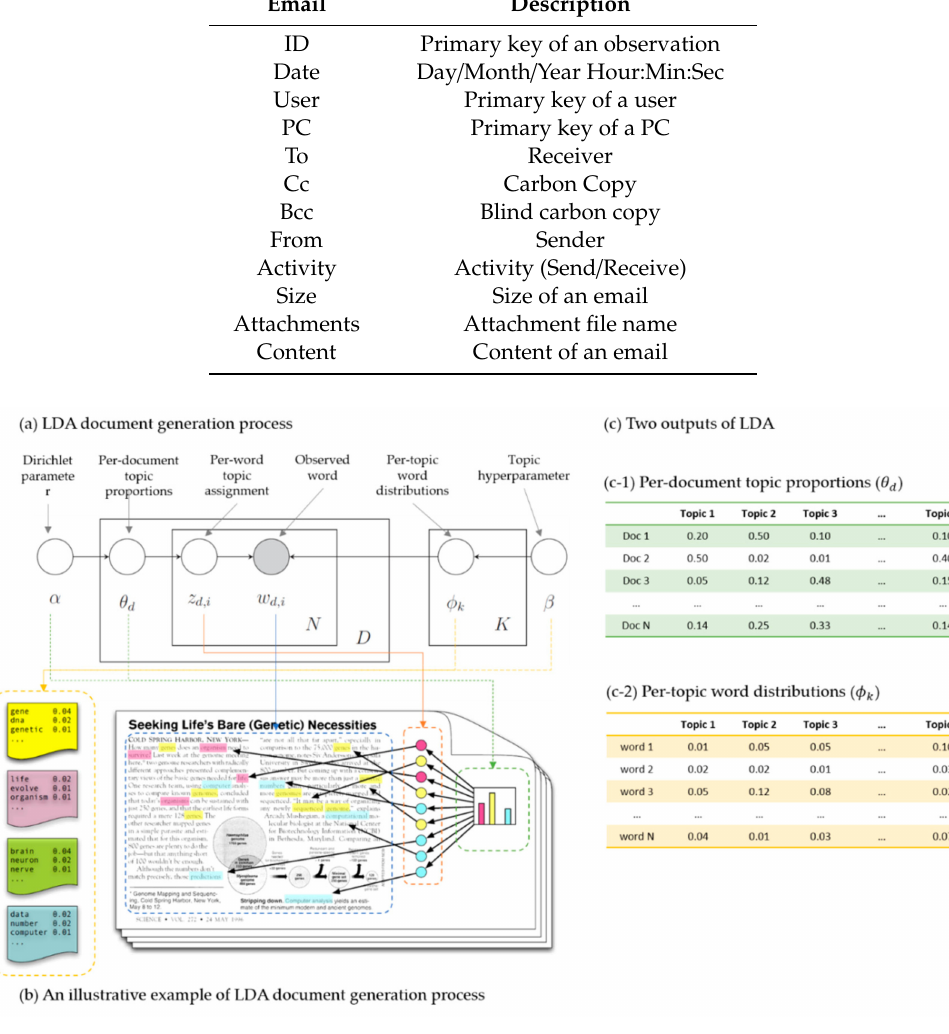
Figure 1. Latent Dirichlet allocation (LDA) process and its two outputs. ( a ) LDA document generation process, ( b )An illustrative example of the LDA document generation process, ( c ) Two outputs of LDA ((c-1) Per-document topic proportions ( θ d ), (c-2) Per-topic word distributions ( Φ k